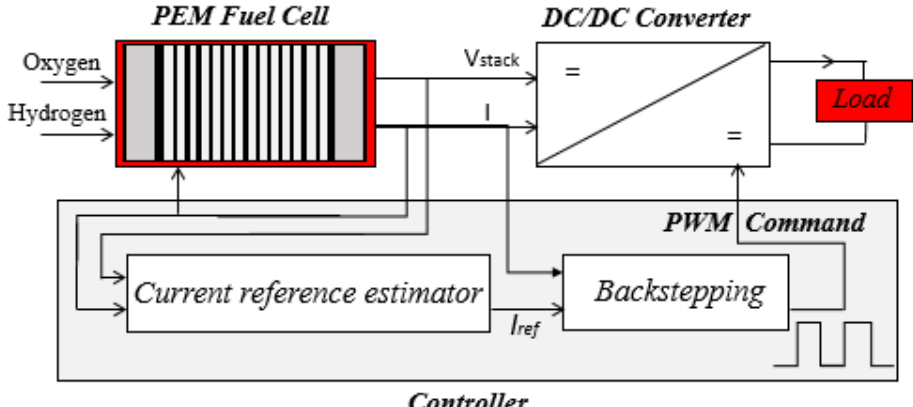
Figure 6. Overview of the designed maximum power point tracking